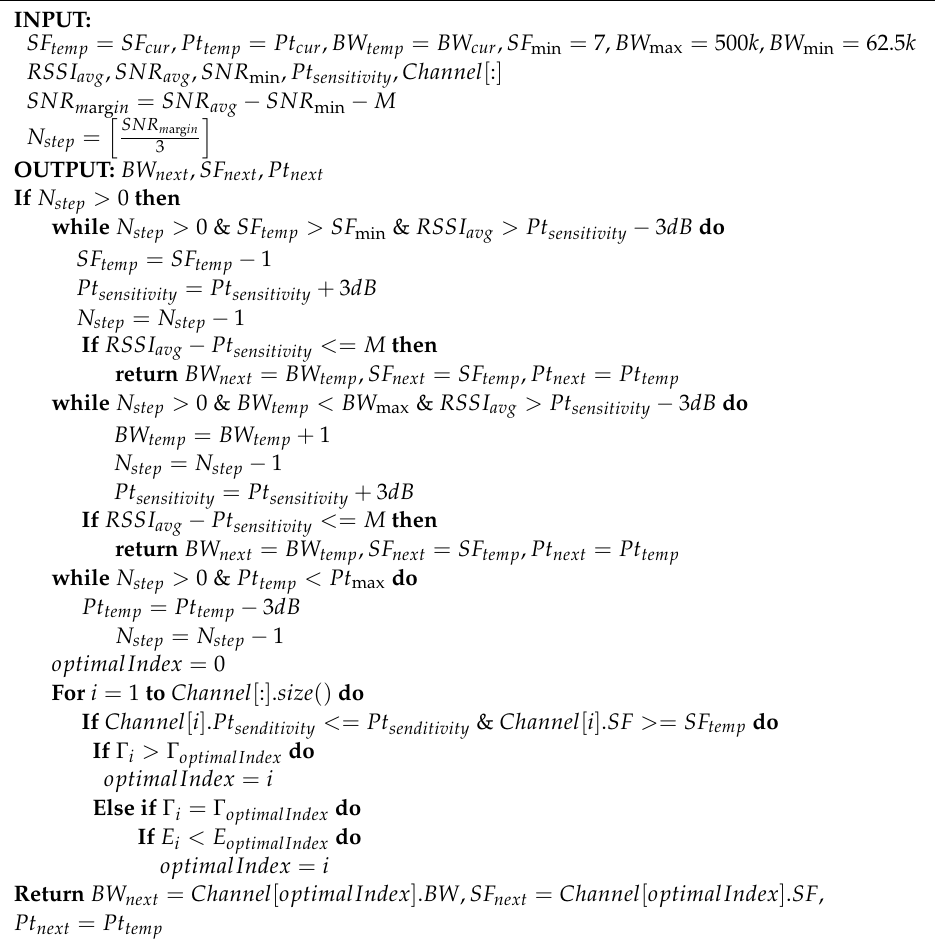
Algorithm 1: Good Link Quality Link Parameter Adaptation Algorithm